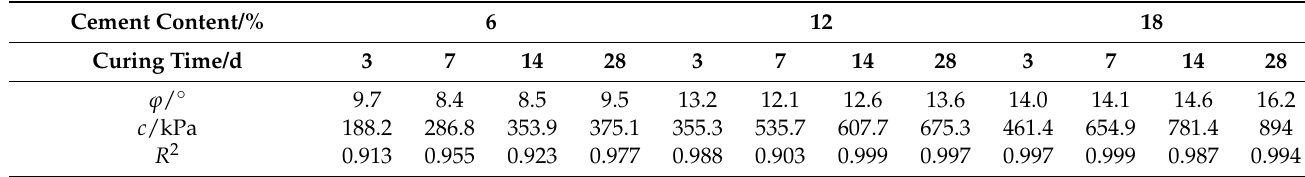
Table 4. Shear index of the cemented